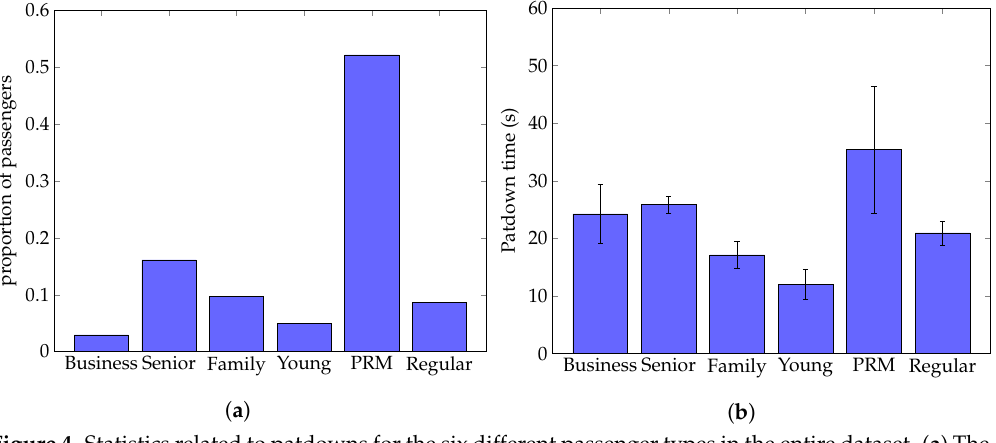
Figure 4. Statistics related to patdowns for the six different passenger types in the entire dataset. ( a ) The proportion of passengers that receive a patdown. ( b ) The mean patdown time of passengers, along with the standard errors.